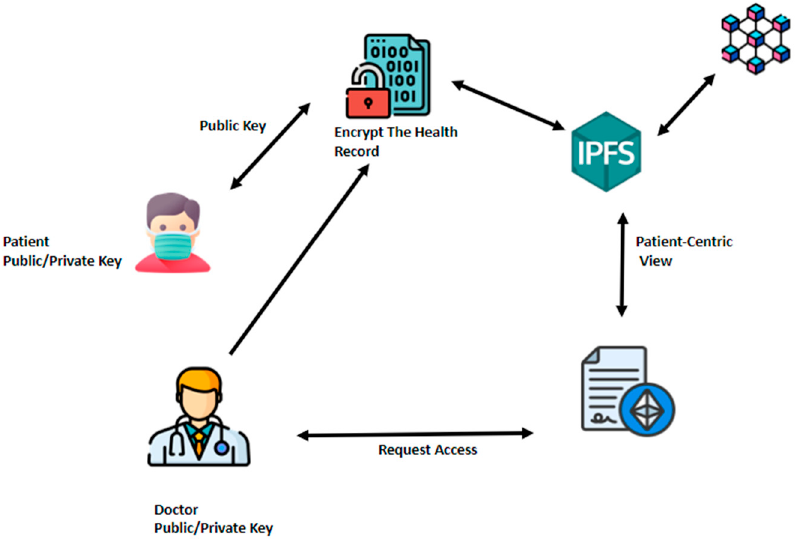
Figure 5. Collaboration diagram between patient and doctor in PCEHRM.